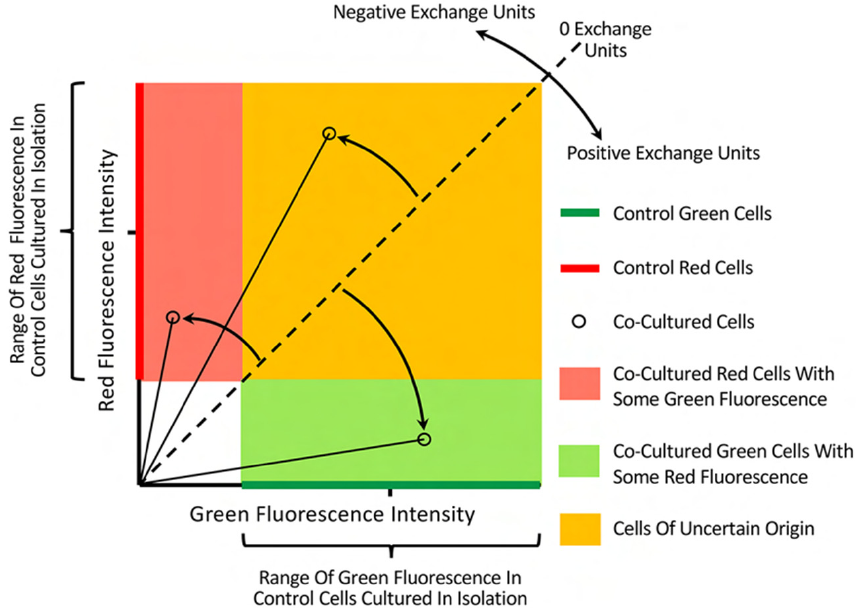
Figure 2. Diagram outlining Cartesian plot analysis of fluorescence transfer in co-cultures. Green and red fluorescence of cells in control populations cultured alone, was recorded along the x and y axes, respectively. The location of individual co-cultured cells was then defined by green and red fluorescence in the cartesian plane, and their position relative to control cells identified them as belonging to one of five separate populations in the co-culture. Co-cultured cells with fluorescence indistinguishable from that of control populations were defined as being either ‘red’ or ‘green’ cells, respectively. Co-cultured cells with fluorescence within the range of one of the control cell populations, but less than the fluorescence of the opposing cell type, were identified as belonging to